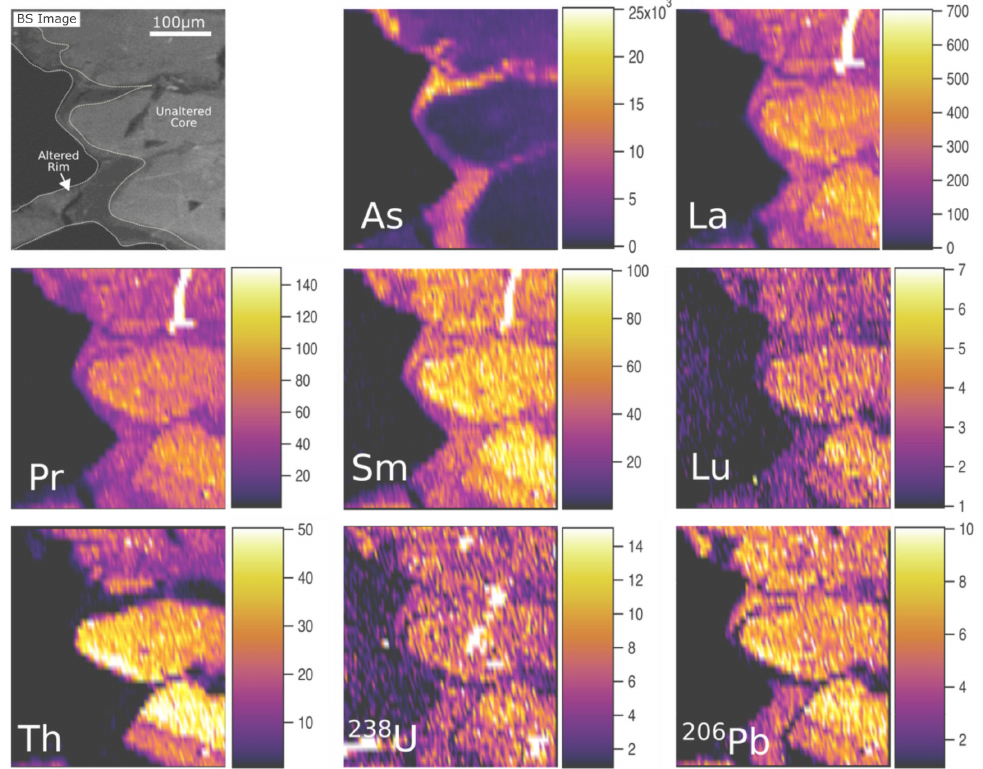
Figure 10. Elemental maps produced across the altered (BC10b) rim to the unaltered (BC10a) core from sample BC10. The BS image of the sample is shown on the top left. The apatite’s core is relatively enriched in LREEs and HREEs. 238 U and 206 Pb is consistent across the unaltered core and altered rim. As is significantly enriched in the altered rim of the grain, while Th is significantly depleted. All concentrations are in